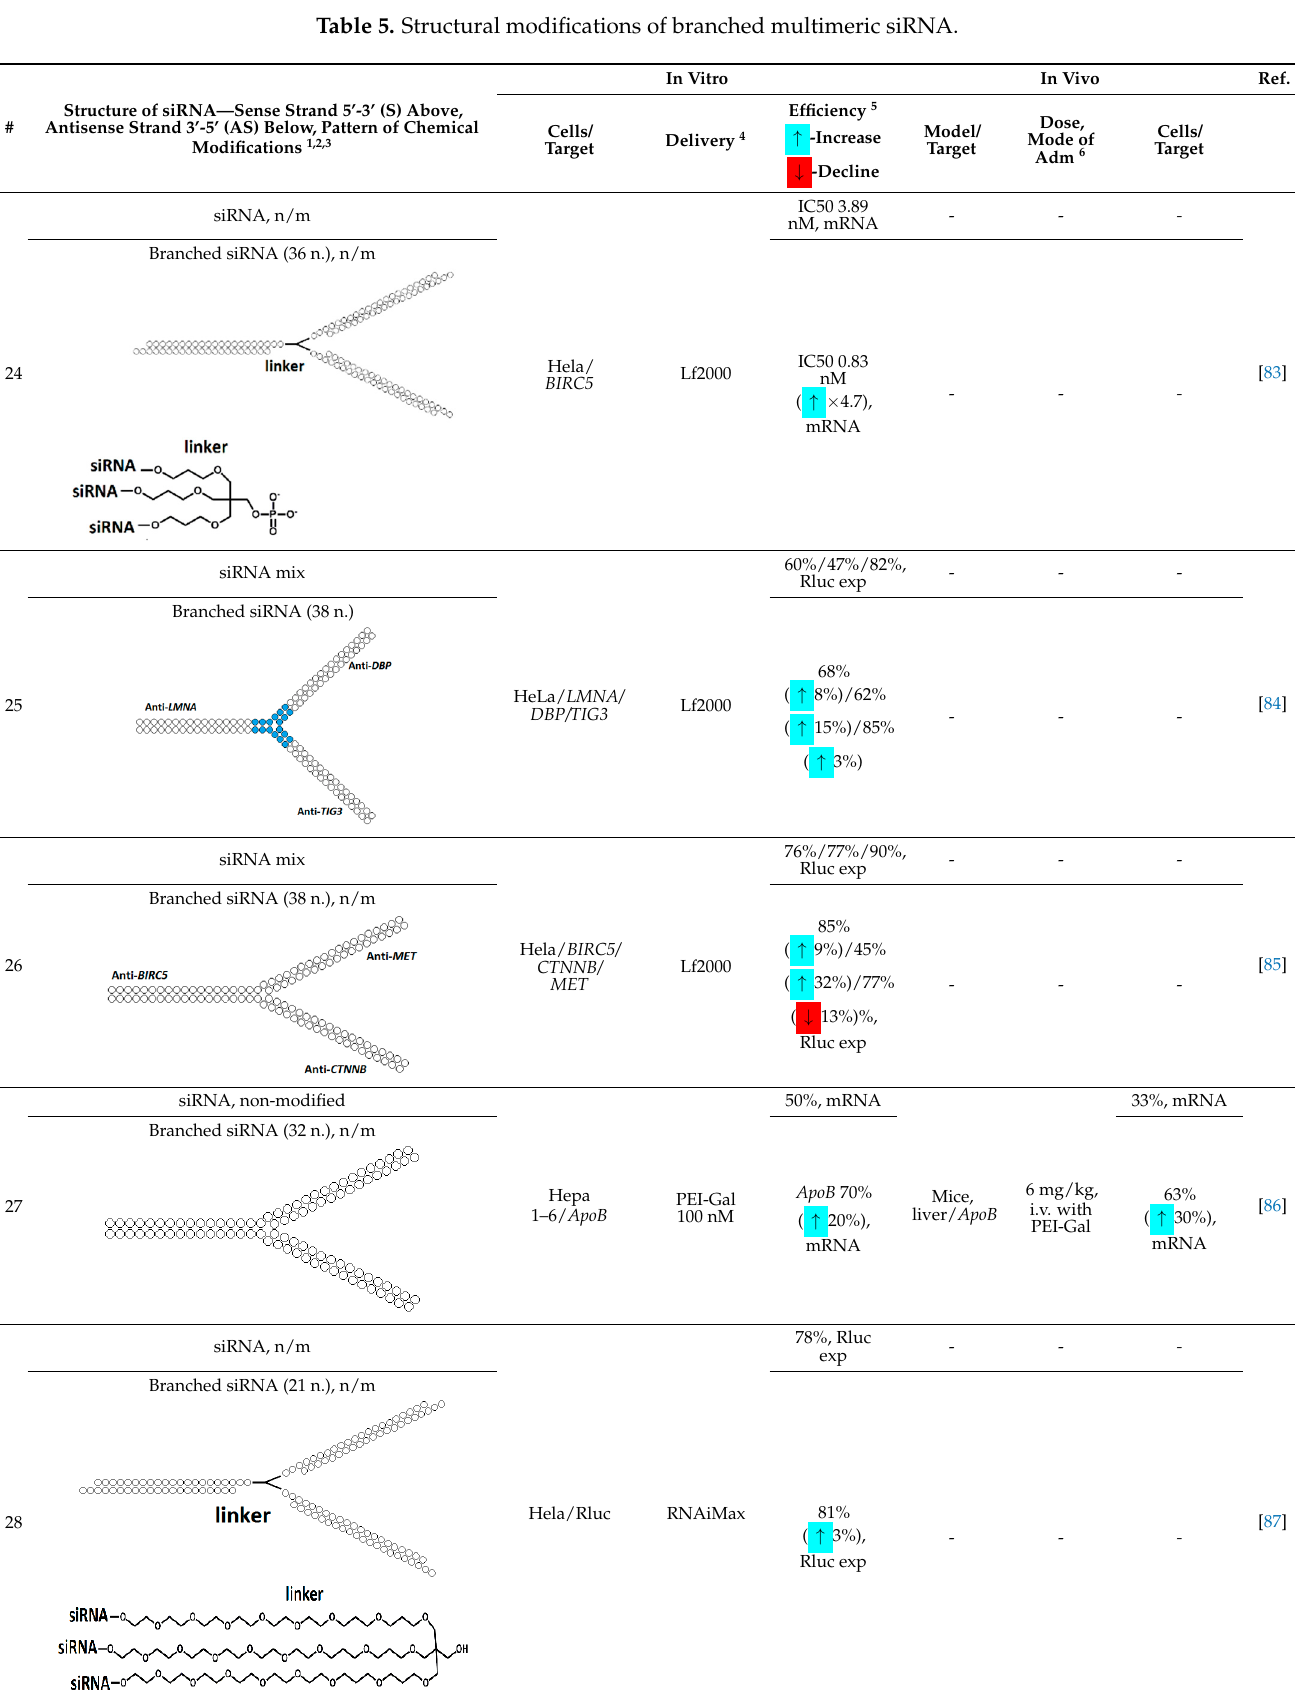
Table 5. Structural modifications of branched multimeric siRNA. Structure of siRNA—Sense Strand 5’-3’ (S) Above, Antisense Strand 3’-5’ #